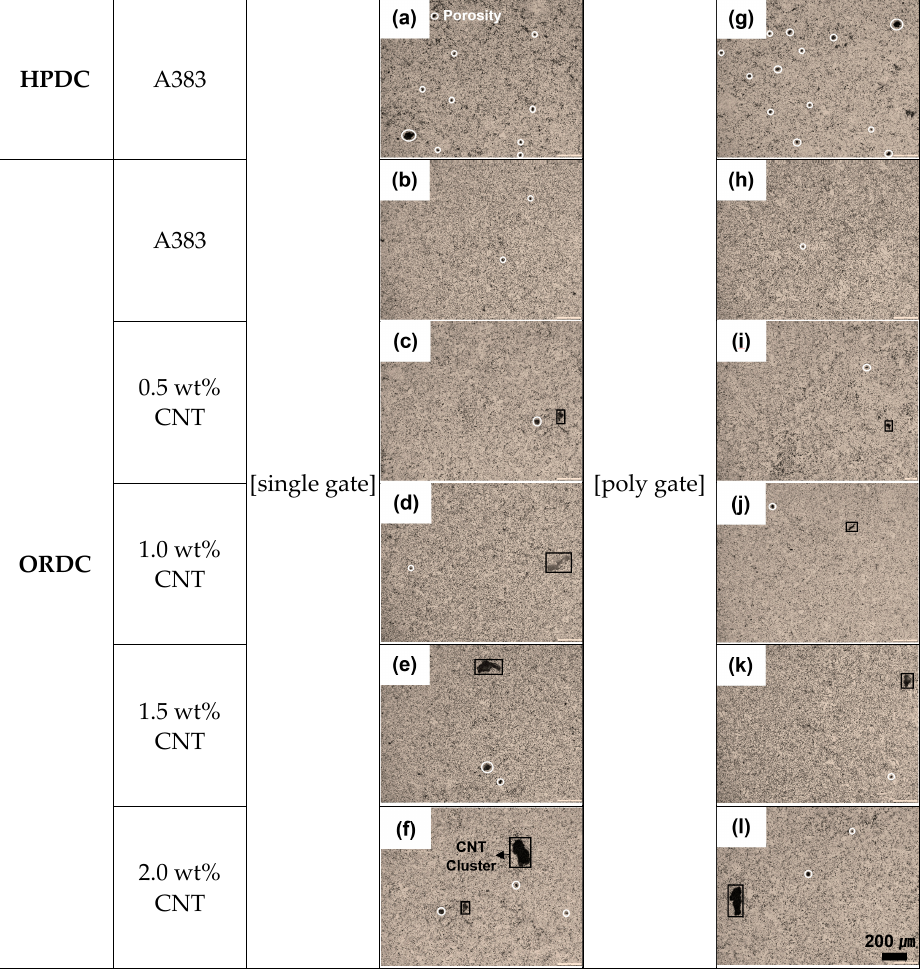
Figure 5. Optical microstructures of A383 alloy cast using a single gate and poly gate by using ( a , g ) HPDC and ( b , h ) ORDC, respectively; 0.5–2.0 wt% CNT-added composites cast using ( c – f ) a single gate and ( i – l ) poly gate by using ORDC.